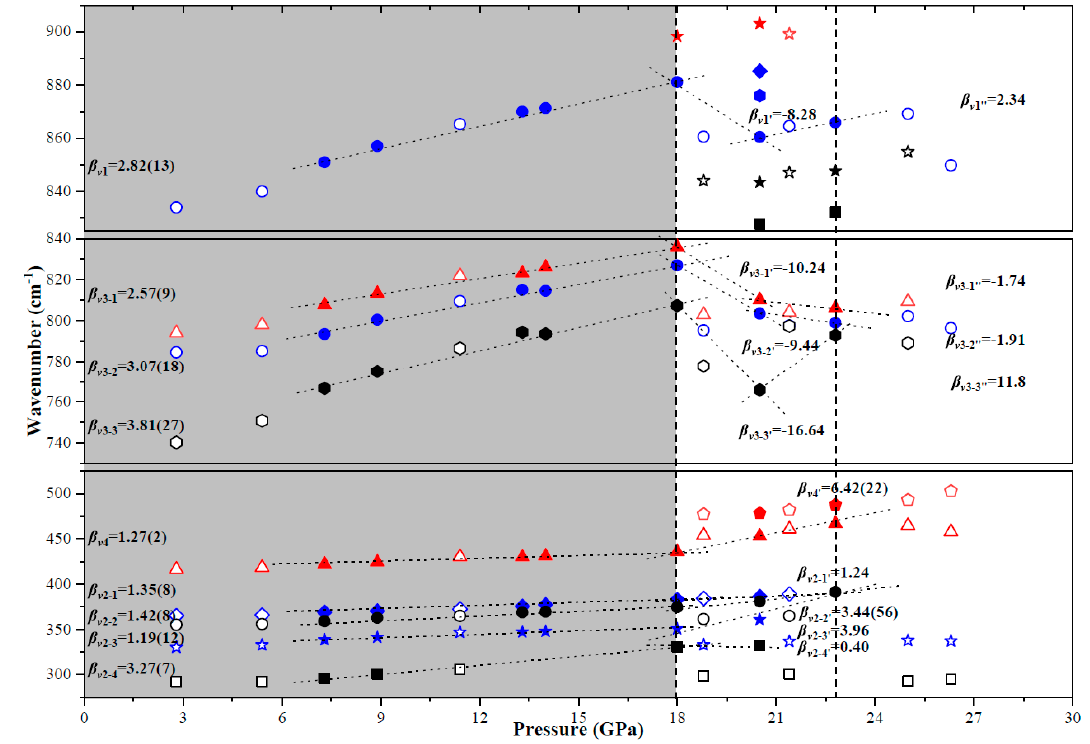
Figure 7. Evolution of Raman modes with pressure in vanadinite. The peaks upon compression and decompression are represented by solid-filled symbols and open ones, respectively. The dashed lines indicate the phase transition zone. The dot lines are guides for eyes.